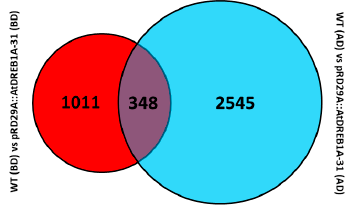
Figure 3. Venn diagram analysis of DEGs between two comparisons (WT (BD) versus pRD29A::AtDREB1A-31 (BD) and WT (AD) versus pRD29A::AtDREB1A-31 (AD)). WT, wild type; pRD29A::AtDREB1A-31, pRD29A::AtDREB1A transgenic line 31. BD, before drought; AD, after six days of drought.